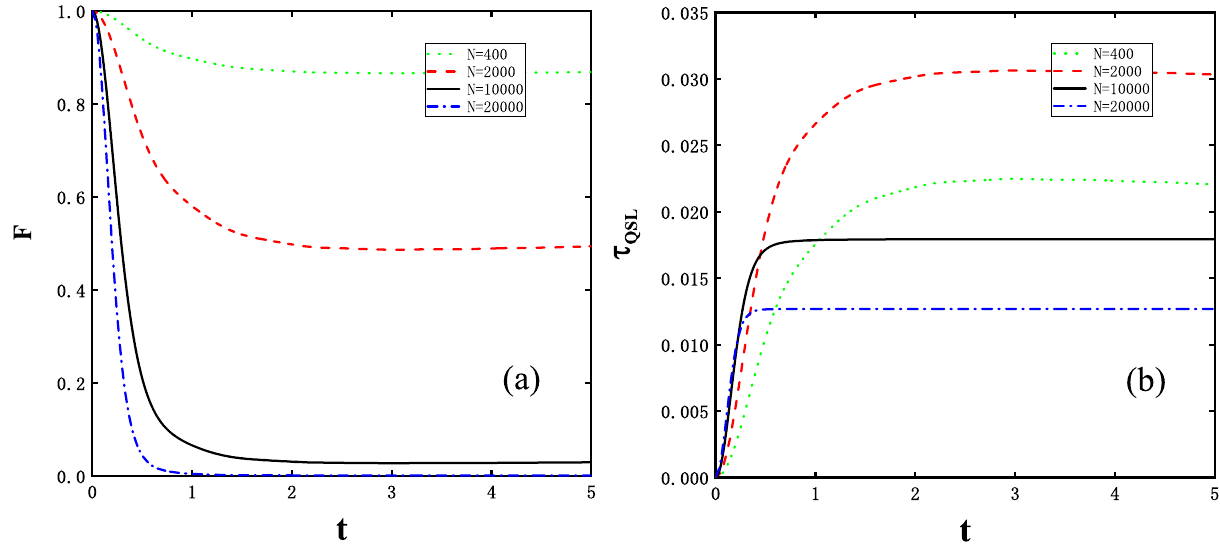
Figure 4. Finite temperature T = 0.5. ( a ) the fidelity F and ( b ) the QSL time τ QSL as functions of time t at different N (see legend), where in both panels the coupling strength, anisotropy value and external magnetic 1 , respectively. It can be obviously seen that either panels 0.05 , γ 1 , and criticality (cid:31) field are constant δ c = = = show a sharp decay or increase to a stable minimum or maximum